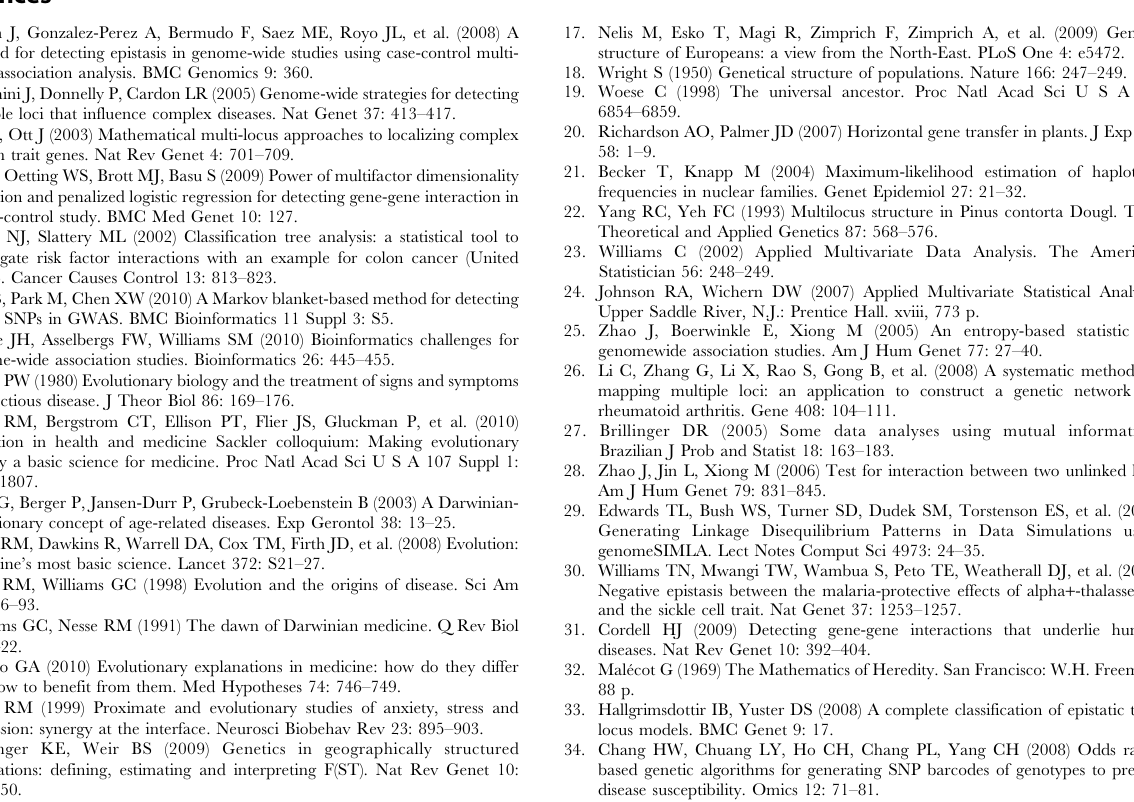
Figure S1 Comparison of the elements in two